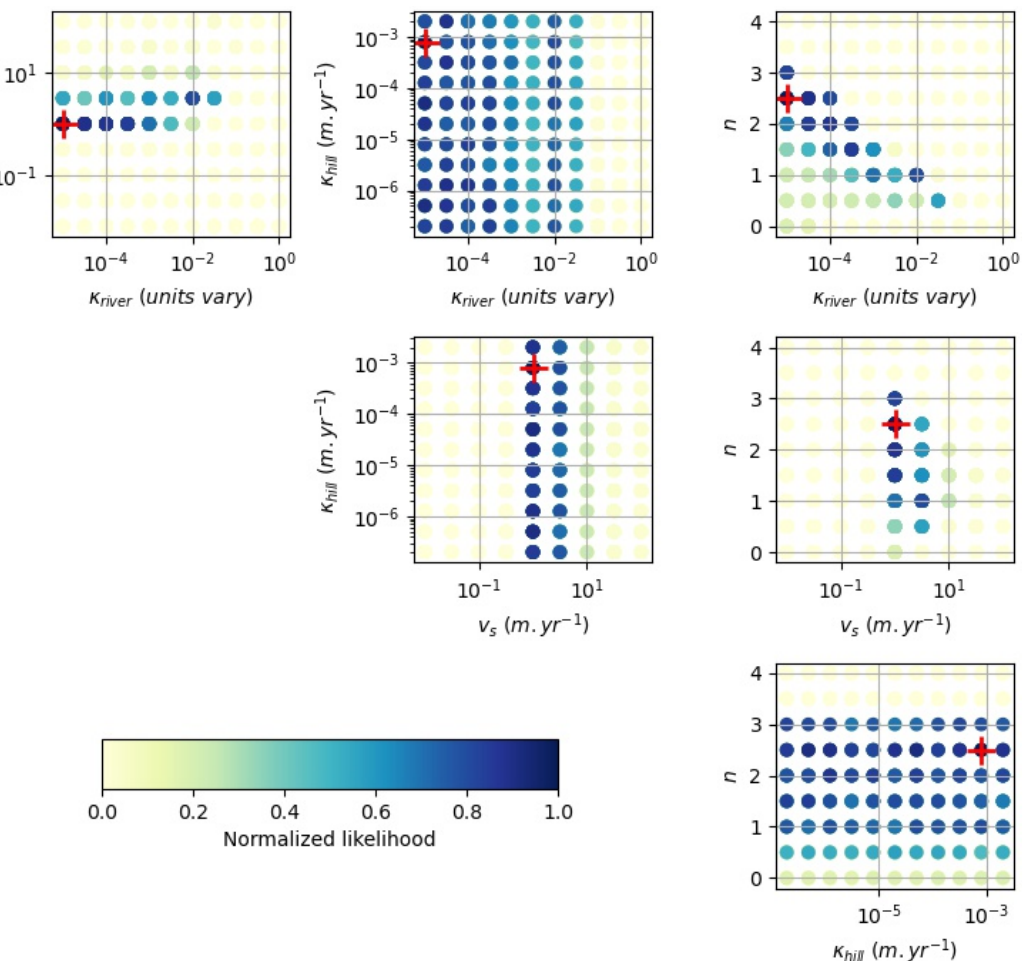
Figure 5. Normalized likelihood distribution of numerical modeling parameters calculated from alluvial fan geometries obtained in eight experimental models (see Figure 3). κ river is the river bedrock erodibility. Its unit depends on the water discharge exponent m , which is defined as m = 0.5 n in this study. n is the slope exponent. v s is the net settling velocity. κ hill is the erodibility coefficient associated with the hillslope process. A red cross is associated with the best-fitting model with κ river = 10 − 5 , v s = 1 m.yr − 1 , κ hill = 8.10 − 4 m.yr − 1 and n = 2.5 .